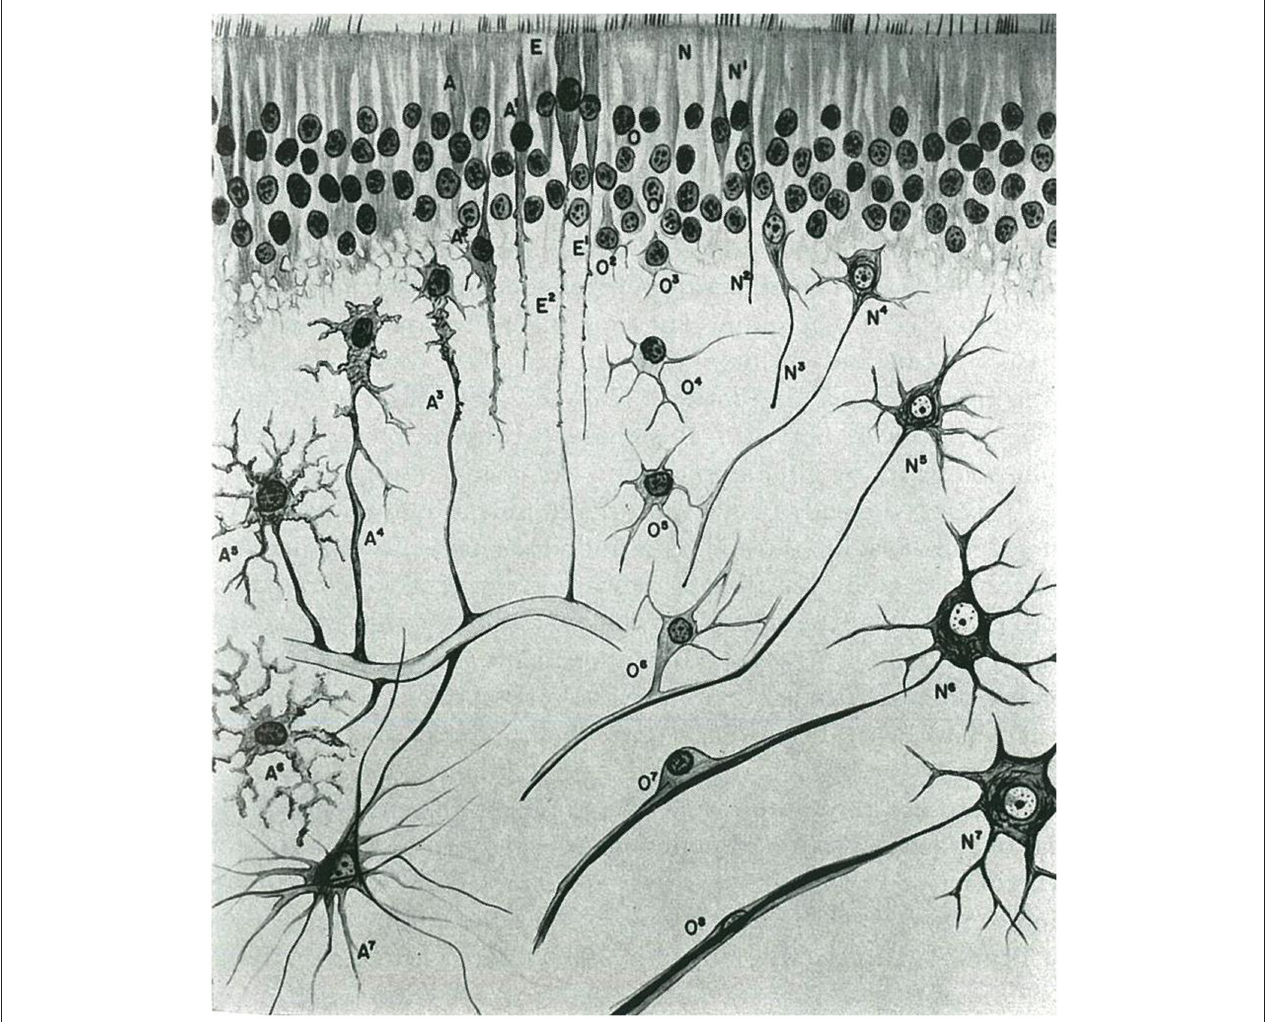
FIGURE 1 | Morphological evolution of the cells that are derived from the neural epithelium in the central nervous system (taken from Río-Hortega, 1933a